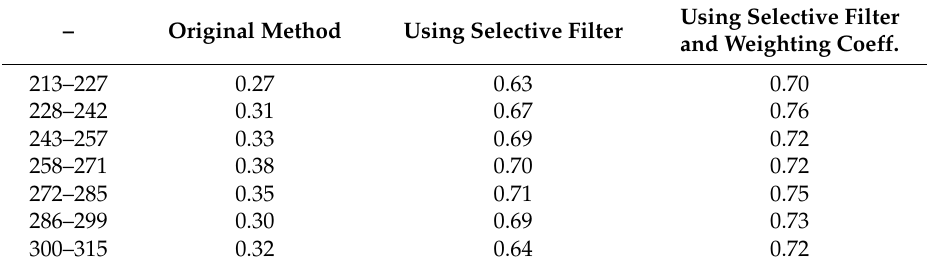
Table 2. Coefficient of determination (R 2 ) of acquired vegetation temperature condition indexes (VTCIs) for different dates before and after